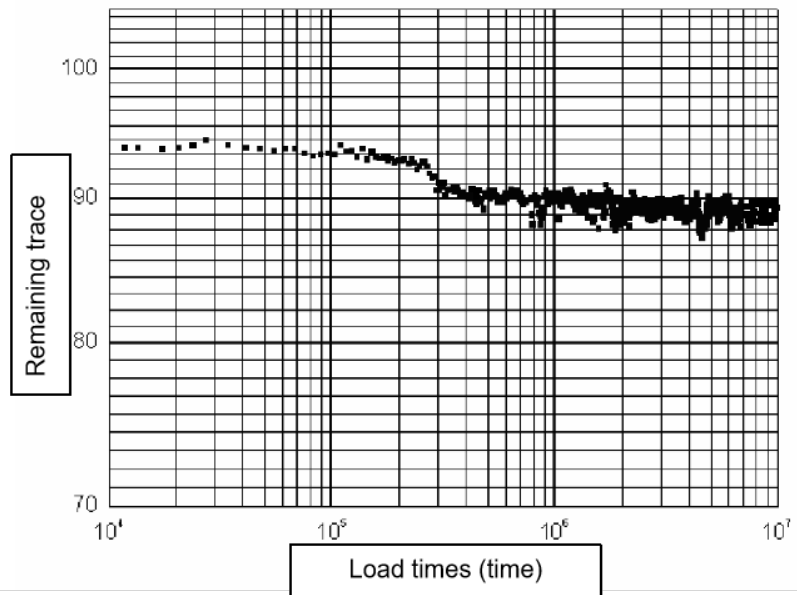
Figure 6. Fatigue endurance test curve of epoxy asphalt mixture.